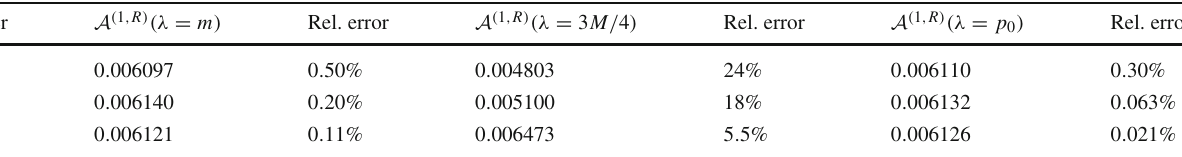
Table 3 Integrated results of the expansion in Eq. (38) evaluated at λ = m , λ = 3 M / 4 and λ = p 0 , with parameters M = 10 m , p 2 = 3 m 2 , and μ = M , compared to the full result of A ( 1 , R ) = 0 . 006128 UV